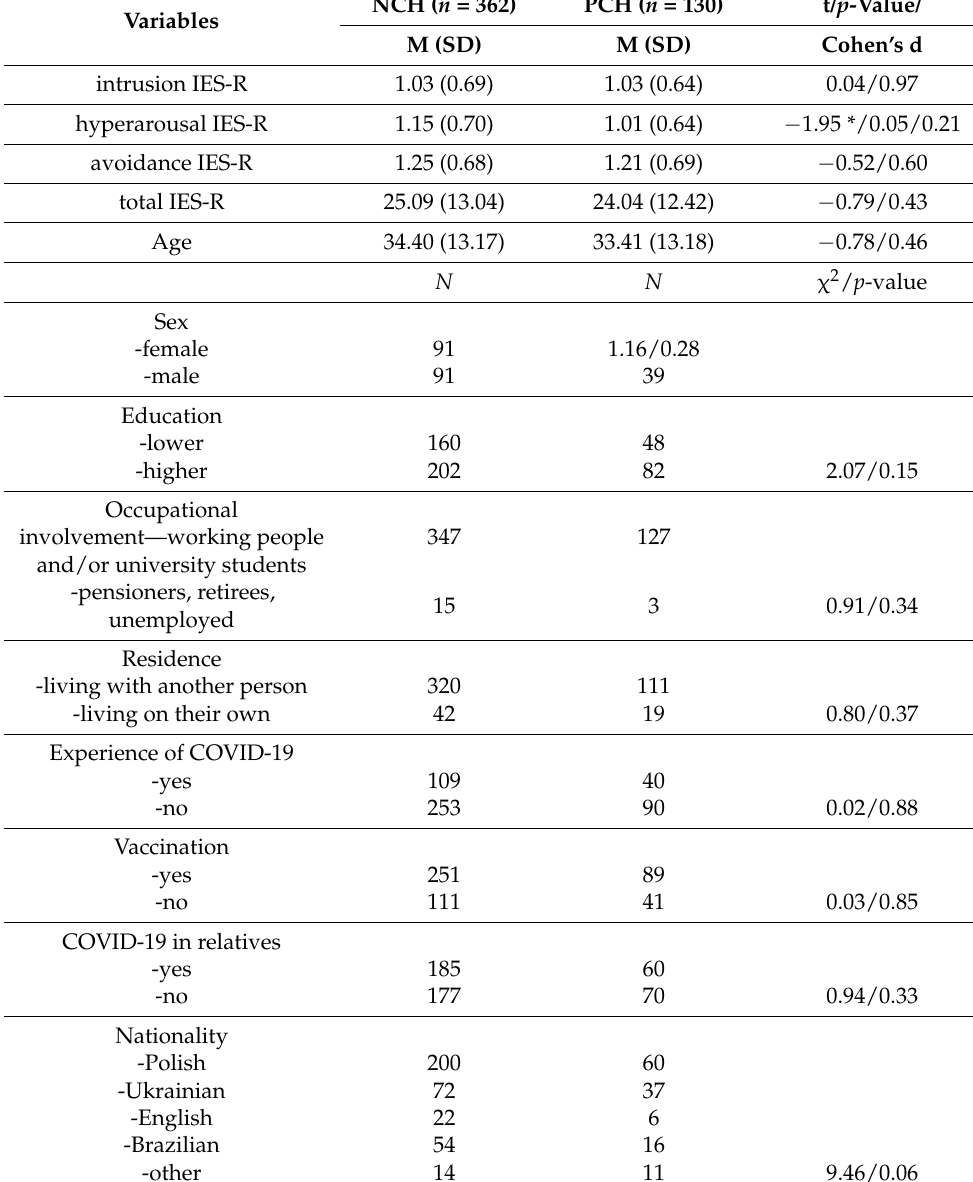
Table 4. Characteristics of participants with negative (NCH) and positive (PCH) sense of